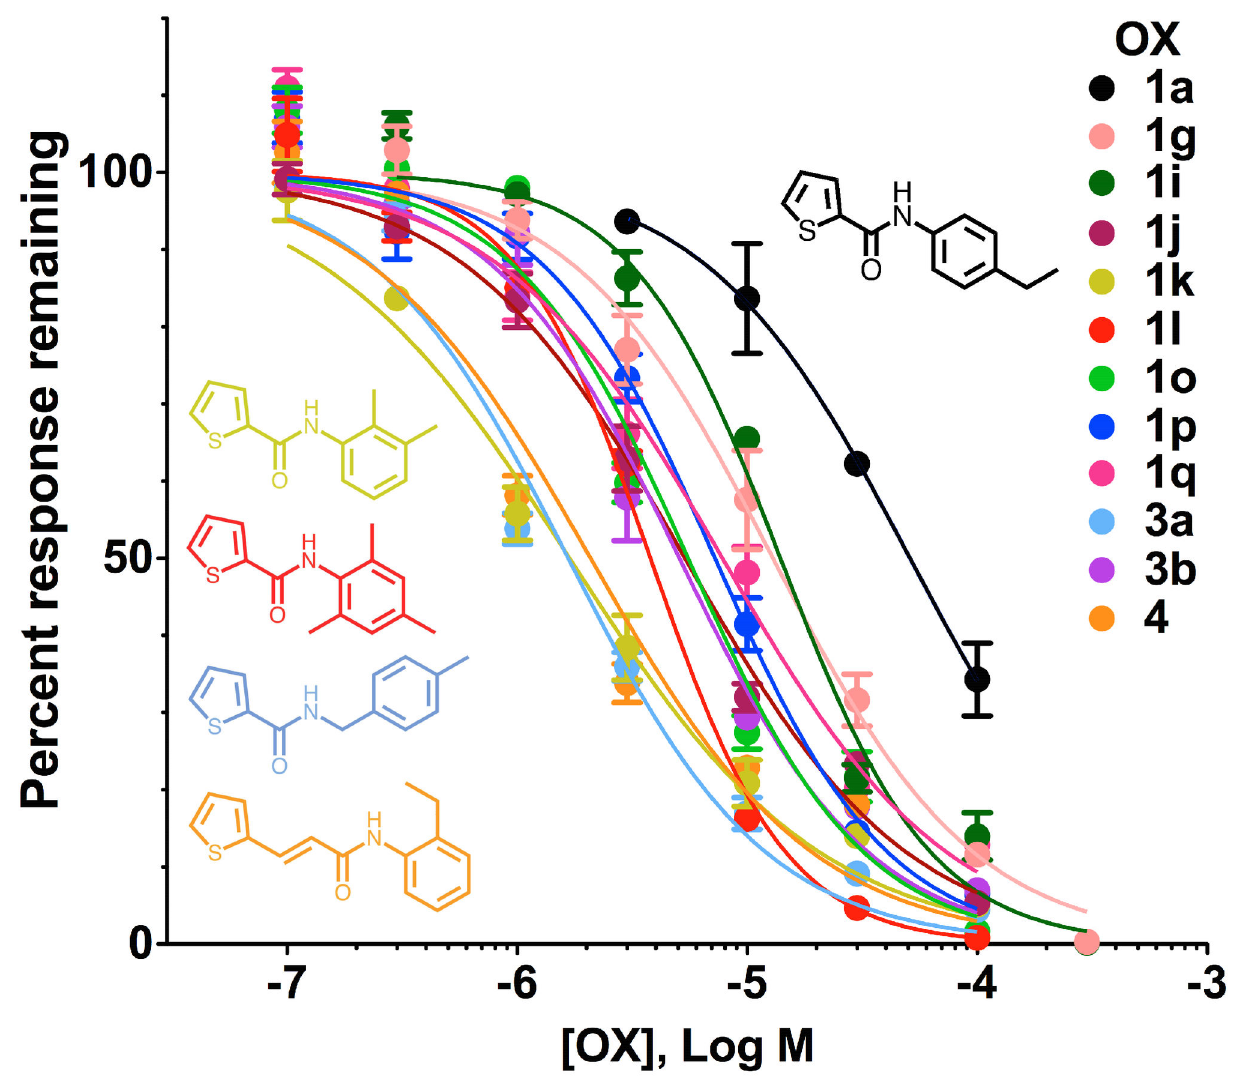
Figure 4. Concentration-inhibition curves for OX1a, OX1g, OX1i, OX1j, OX1k, OX1l, OX1o, OX1p, OX1q, OX3a, OX3b and OX4 inhibition of Cqui\Orco+Cqui\Or21 activated by 3 µM OLC12. IC doi: